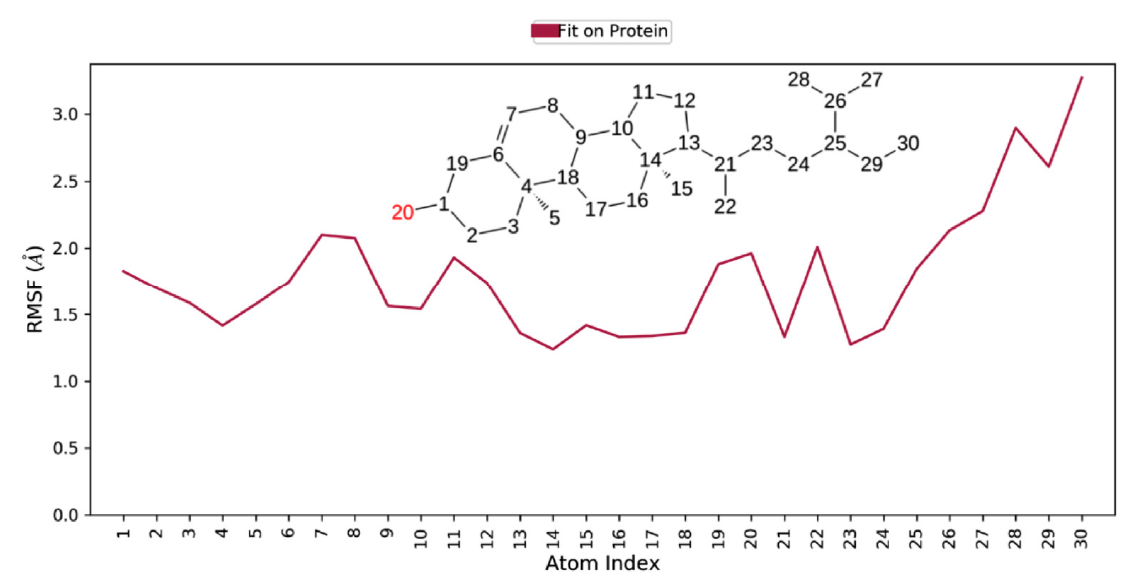
Figure 6. Ligand RMSF plot of beta-sitasterol in complex with 6IE9: X -axis depicts atom index and Y -axis reveals RMSF (Å).20 stands for atom number which is oxygen